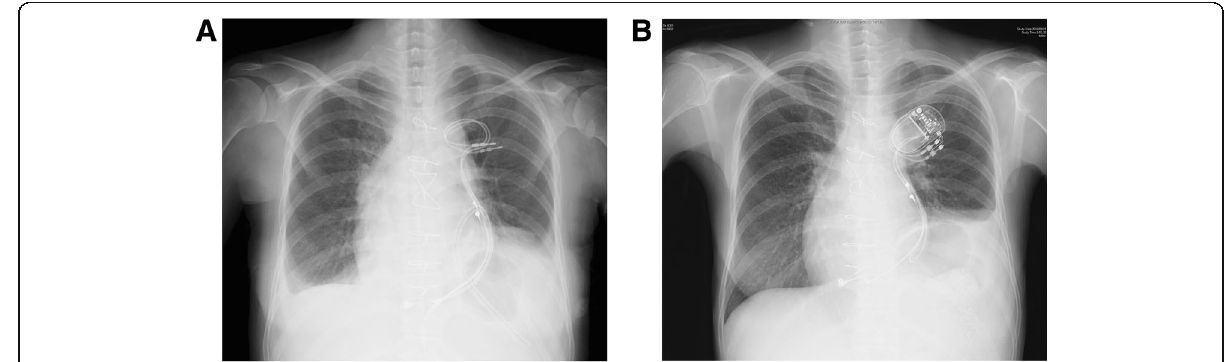
Fig. 1 The chest X-ray images a immediately after the TCPC conversion on the fourth postoperative day and b on the current admission, showing significant elevation of the left dome of the diaphragm, suggesting left hemidiaphragmatic